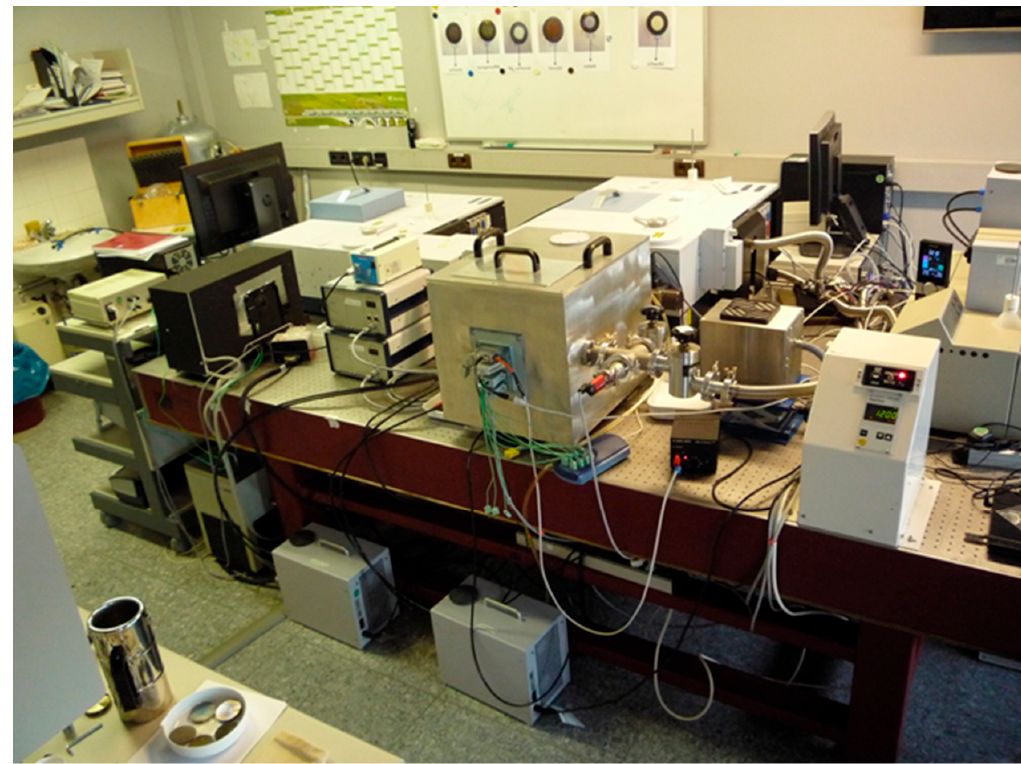
Figure A7. The laboratory setup at Planetary Spectroscopy Laboratory (PSL).